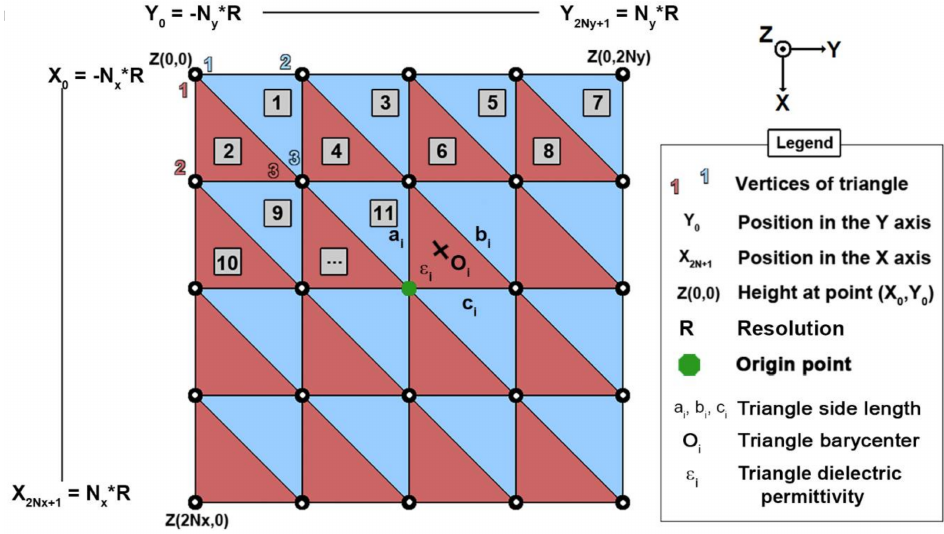
Figure A1. Meshgrid representing the coordinate system and norms used in CALM. In this example, Nx = Ny =